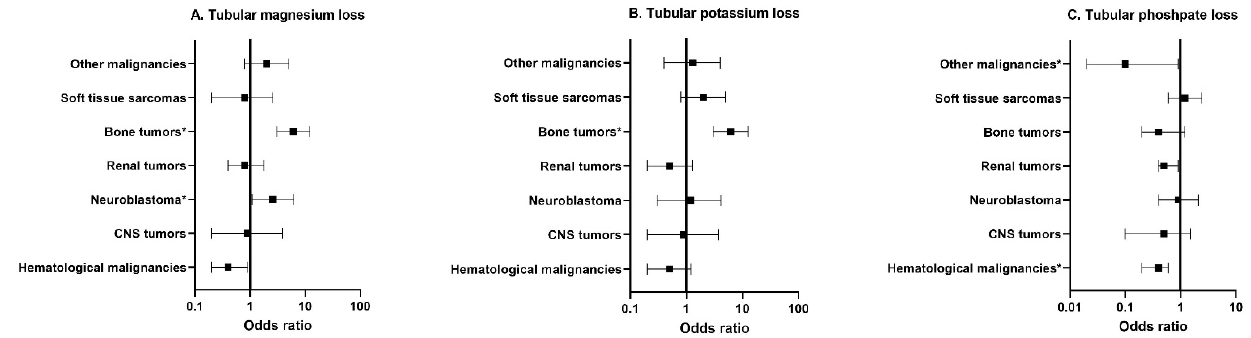
Figure 3. Multivariable logistic regression analyses among different tumor types for tubular outcomes including: ( A ) tubular magnesium loss; ( B ) tubular potassium loss; ( C ) tubular phosphate loss. This figure displays the odds ratios in CCS compared to controls. Exact values of the odds ratios are listed in Table S2. The square represents the odds ratio, and the horizontal lines represent the 95% confidence interval. The vertical line represents the value 1 (no difference between CCS and controls). The model for tubular magnesium loss is corrected for age at study, estimated glomerular filtration rate and albumin-to-creatinine ratio. The model for tubular potassium loss is corrected for age at study. The model for tubular phosphate loss is corrected for age at study and sex. * = p -value < 0.05. Abbreviations: CCS, childhood cancer survivors; CNS, central nervous system.